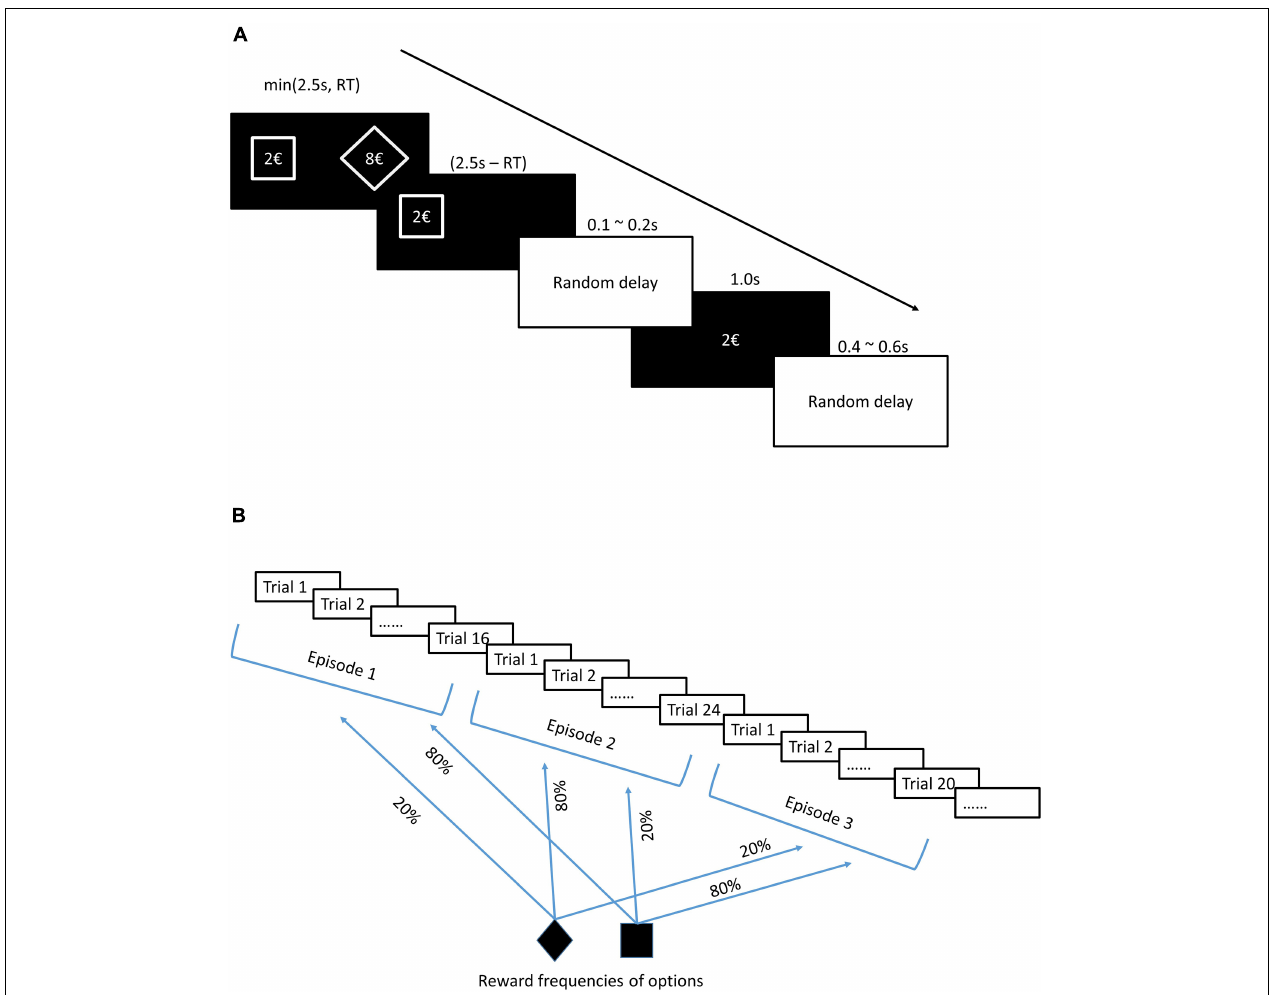
FIGURE 2 | (A) Trial structure. In each trial, subjects see two forms (options), a diamond and a square, each proposing a reward in euros randomly chosen from the set {2, 4, 6, 8, and 10}. After making a choice, subjects only see the chosen option on the screen, followed by a display of the outcome of the choice in the center of the screen. The average duration of a trial was 4.15 s. After displaying two available options on the screen, subjects were given 1.5 s for thinking and responding by pressing one of two instructed buttons on the keyboard, left button for choosing the option on the left side of the screen and right button for choosing the option on the right side of the screen. The outcome of the trial was displayed 1.0 s. The delay of the outcome display was 0.1–0.2 s. The inter-trial delay was 0.4–0.6 s. (B) Experimental design. The outcome could be zero or equal to the proposed reward (shown on the first screen of each trial) with some probability that subjects were not informed about. However, they could derive the reward frequencies through experience. By experimental design, 20 and 80% reward frequencies were assigned to two options and switched between them after a random number of trials (16, 20, 24, or 28). Subjects were not informed about switches but could detect them throughout the experiment based on feedbacks (outcomes). Each subject went through 19 switches of reward frequencies, which divided the task into 20 episodes (a series of trials within which no change of reward frequencies